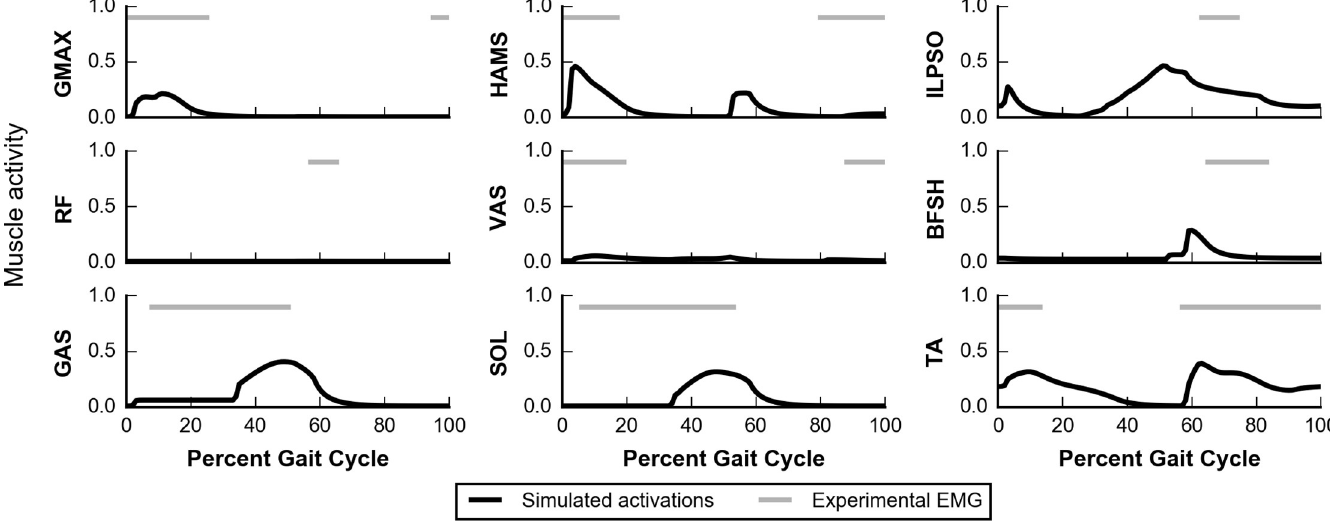
Fig 7. Muscle activity during gait at self-selected speed. Simulated muscle activations (black) are compared to on-off timings estimated from experimental electromyograms (EMG) reported by Perry and Burnfield (gray) [63]. Because the muscles in the model represent groups of muscles, we show on-off timing of multiple muscles for some comparisons (e.g., for HAMS, experimental data represent the long head of the biceps femoris, semitendinosus, and semimembranosus). S3 Table contains more details about these comparisons.